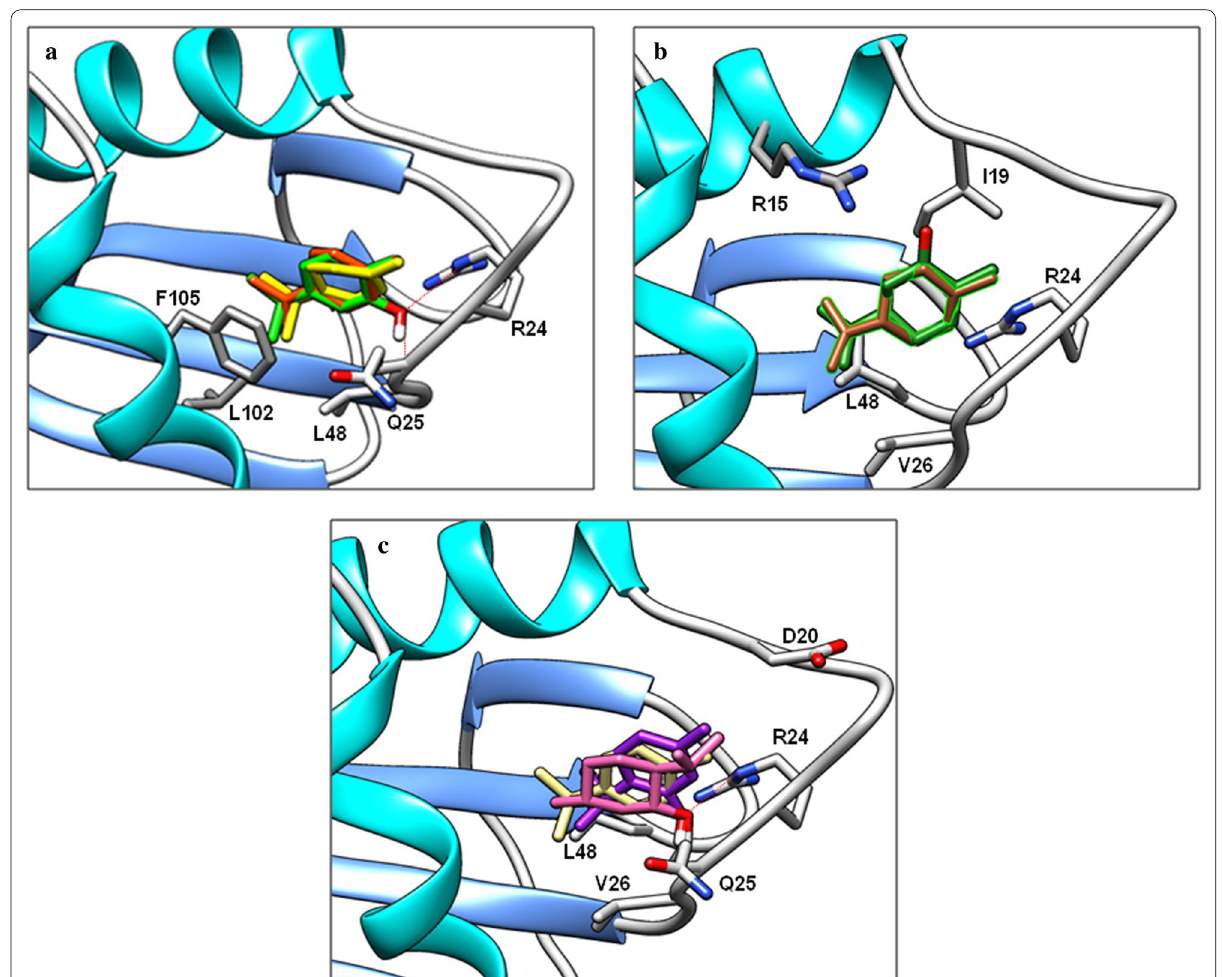
Fig. 7 Interaction of cyclic terpenes and terpenoids with SCP‑2. a Interaction of carvacrol (green), α‑Terpinene (orange) and terpinolene (yellow). b Interaction of limonene (brown) and carvona (green). c Interaction of p ‑cimene (yellow), menthol (pink) and thymol